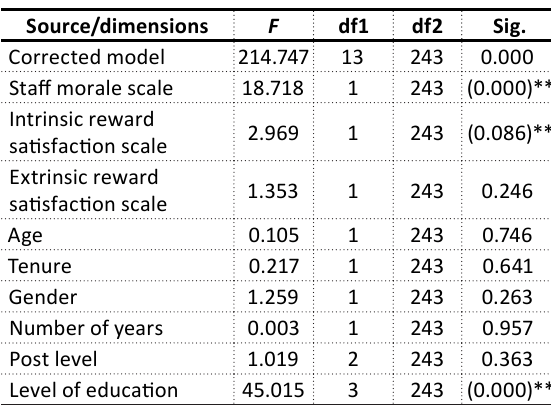
Table 5. Pearson’s product moment